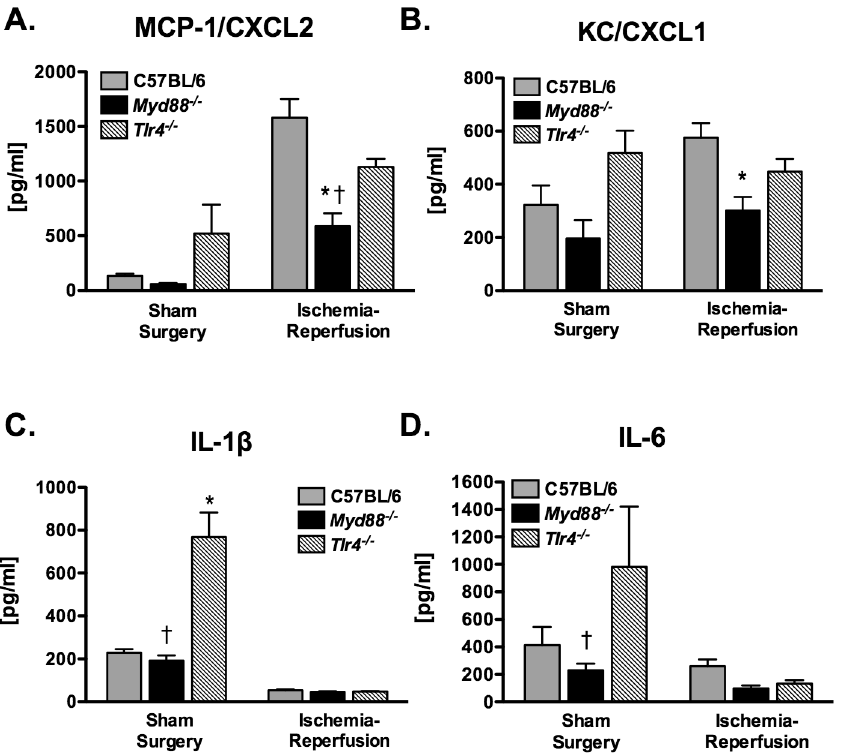
Figure 3. Cytokine concentrations from the right lung of mice subjected to 1 hr of left lung warm ischemia and 4 hr of reperfusion (n = 12/grp for C57BL/6 and Tlr4 -/- ; n=10 for Myd88 -/- ). Sham surgery mice (n = 4/grp) were not subjected to left lung ischemia. *p ≤ 0.05 when compared with the C57BL/6 mice. † p ≤ 0.05 when compared with Tlr4 -/- mice.